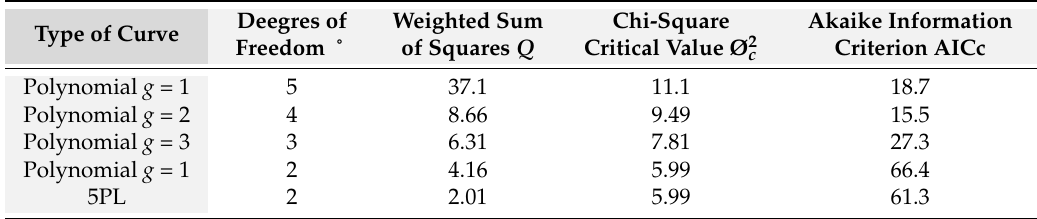
Table 5. Numerical values from calibration of six Biophotonic Sensing Cells (BICELLs) for anti-IgG